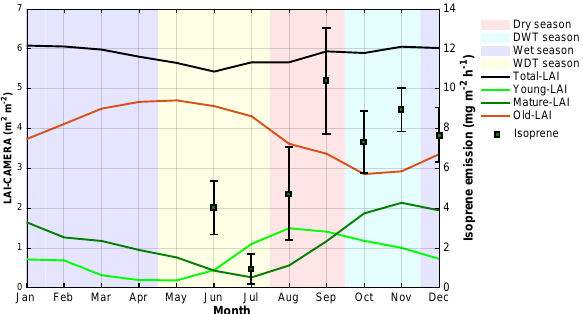
Figure 4. CAMERA-LAI derived for the K34 tower site. CAMERA-LAI data are presented in three different leaf age classes: young LAI, mature LAI, and old LAI. Error bars represent 1 stan- dard deviation from the mean. Background color shadings indicate each season and are explicit in the legend. DWT season and WDT season stand for the dry-to-wet transition season and the wet-to-dry transition season, respectively.